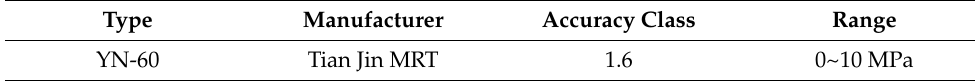
Table 7. The parameters of pressure gauge for hydraulic